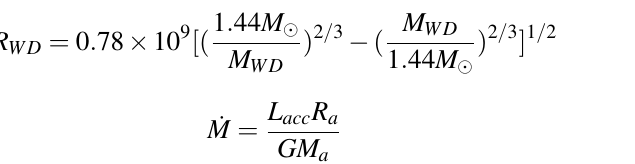
Fig. 6 represents all photometric observations collected through ∼ 17 years at data base of the American Association of Variable Stars Observers (AAVSO). Different characteristic features of DQ Her variations,